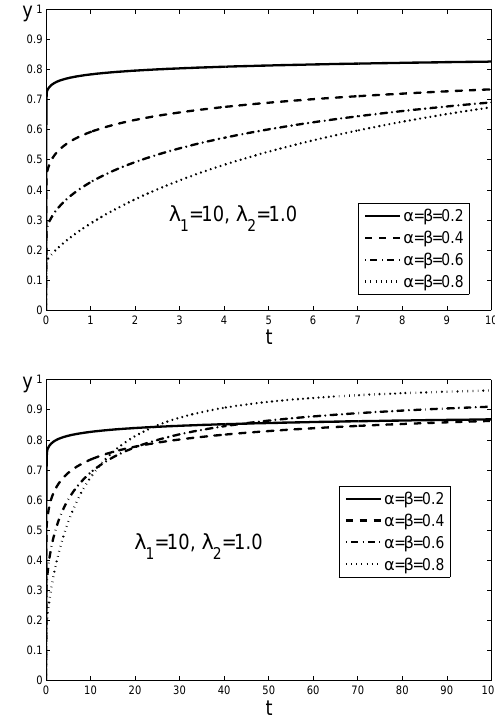
Fig. 6. Time profiles of the pressure gradient for α = β , A = 1 , λ 1 = 10 , λ 2 = 1 . Time interval [0 , 10] (above) and [0 , 100]